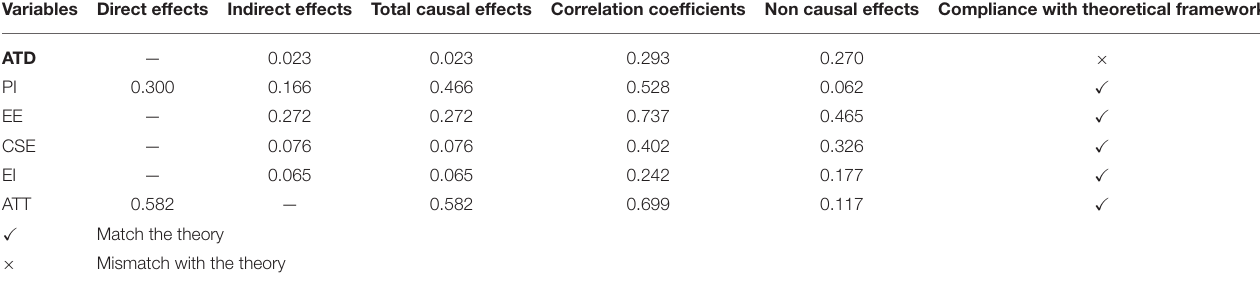
TABLE 5 | Indirect and direct effects on